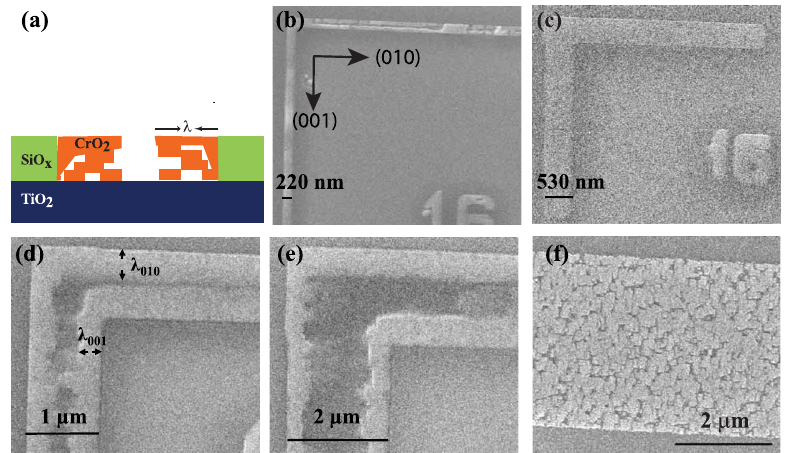
FIG. 1. Early stage growth of CrO 2 wires. (a) Schematic of edge-enhanced nucleation and growth of CrO 2 inside a SiO of L-shaped nanowires along the indicated directions, grown for 20 minutes, with trench widths (b) 220 nm, (c) 530 nm, (d) 1 μ m, and (e) 2 μ m. The measured width of the CrO 2 bars is shown and found to be equal to the trench width. In panel (d), λ is a measure for the surface diffusion length. (f) SEM image of CrO 2 wire fabricated via reactive ion etching of a CrO 2